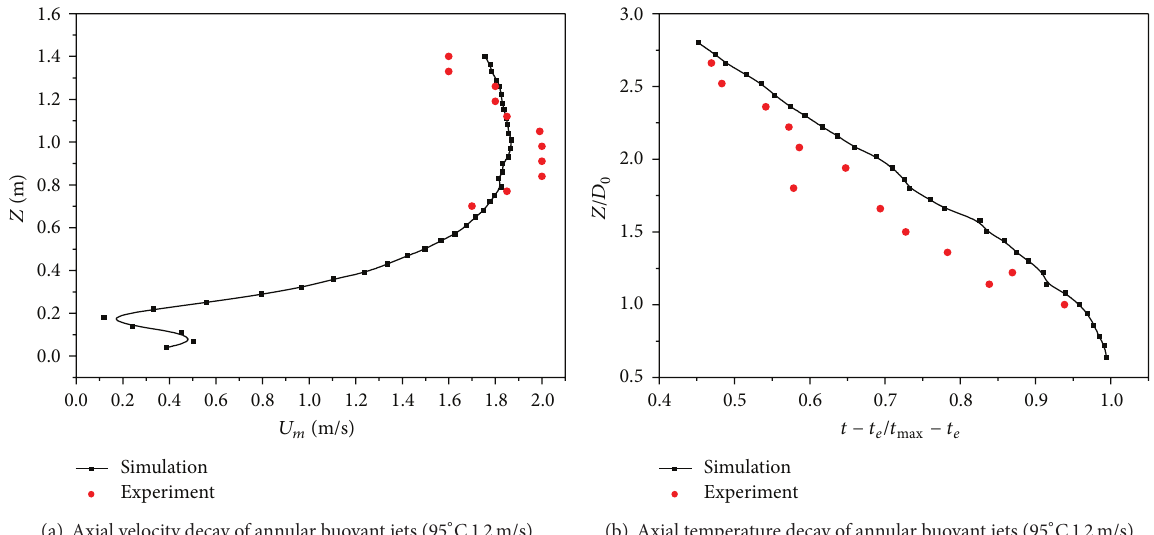
(b) Axial temperature decay of annular buoyant jets (95 ∘ C 1.2m/s) Figure 2: Validation of the computational simulations.